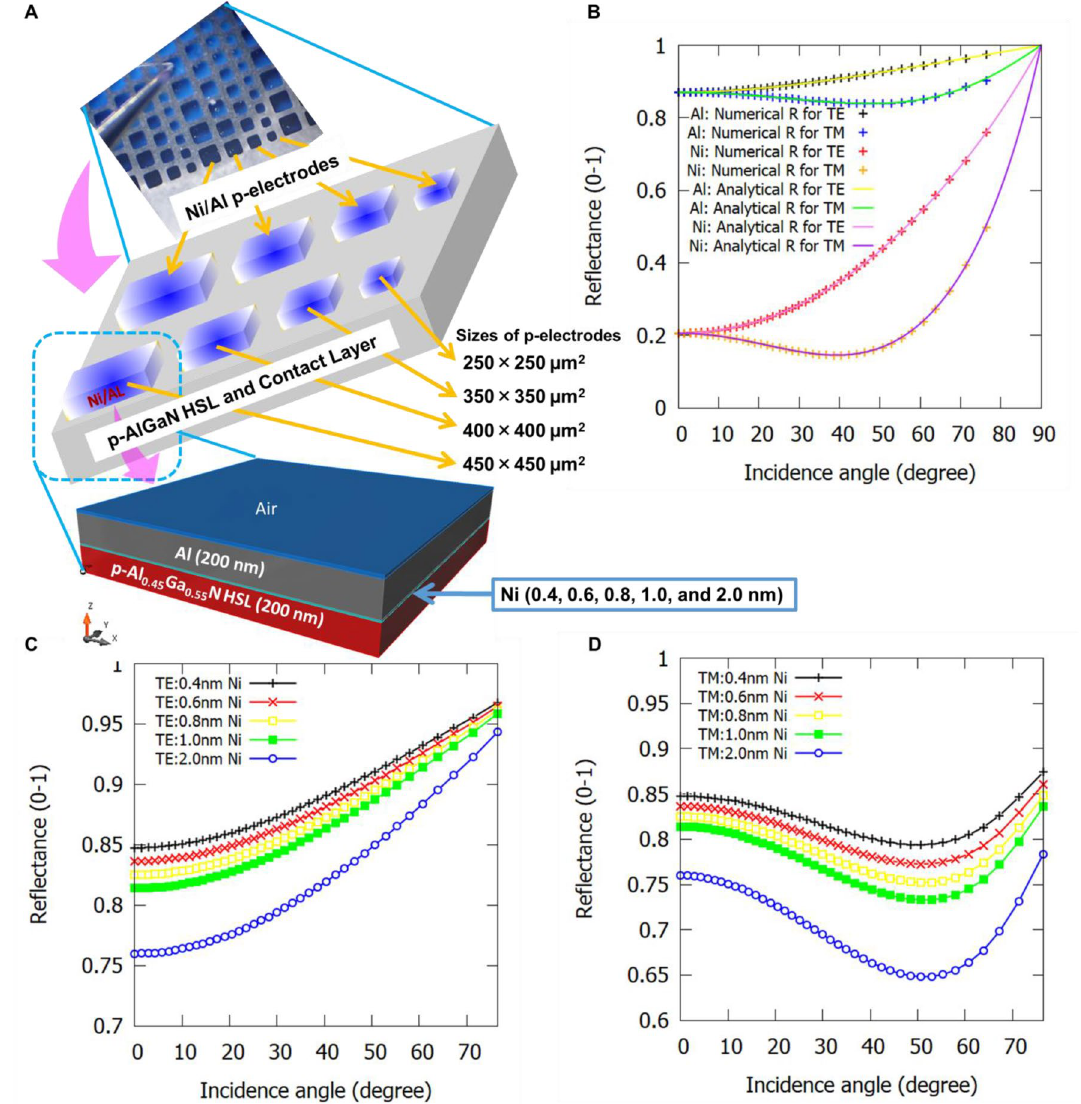
Figure 4. ( a ) 3D simulated unit of Ni/Al p-electrode on the top of p-AlGaN contact-layer, ( b ) Theoretical and numerical reflectance of the individual Ni and Al-metallic layer, ( c ) Incidence angle vs. reflectance from Ni/ Al p-electrode as a function of varying Ni-layer thickness in transverse electric (TE)-mode, and ( d ) Incidence angle vs. reflectance from Ni/Al p-electrode as a function of varying Ni-layer thickness in transverse magnetic